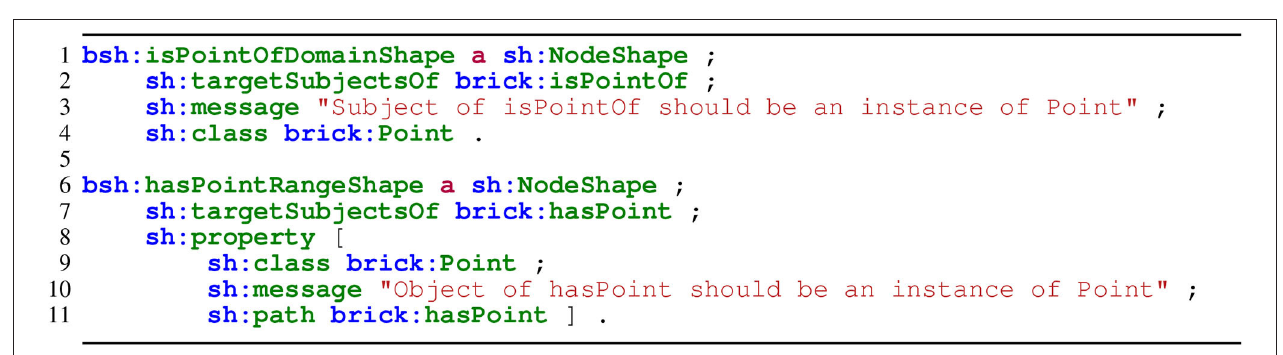
FIGURE 10 | SHACL shapes defining correct usage of the brick:isPointOf and brick:hasPoint